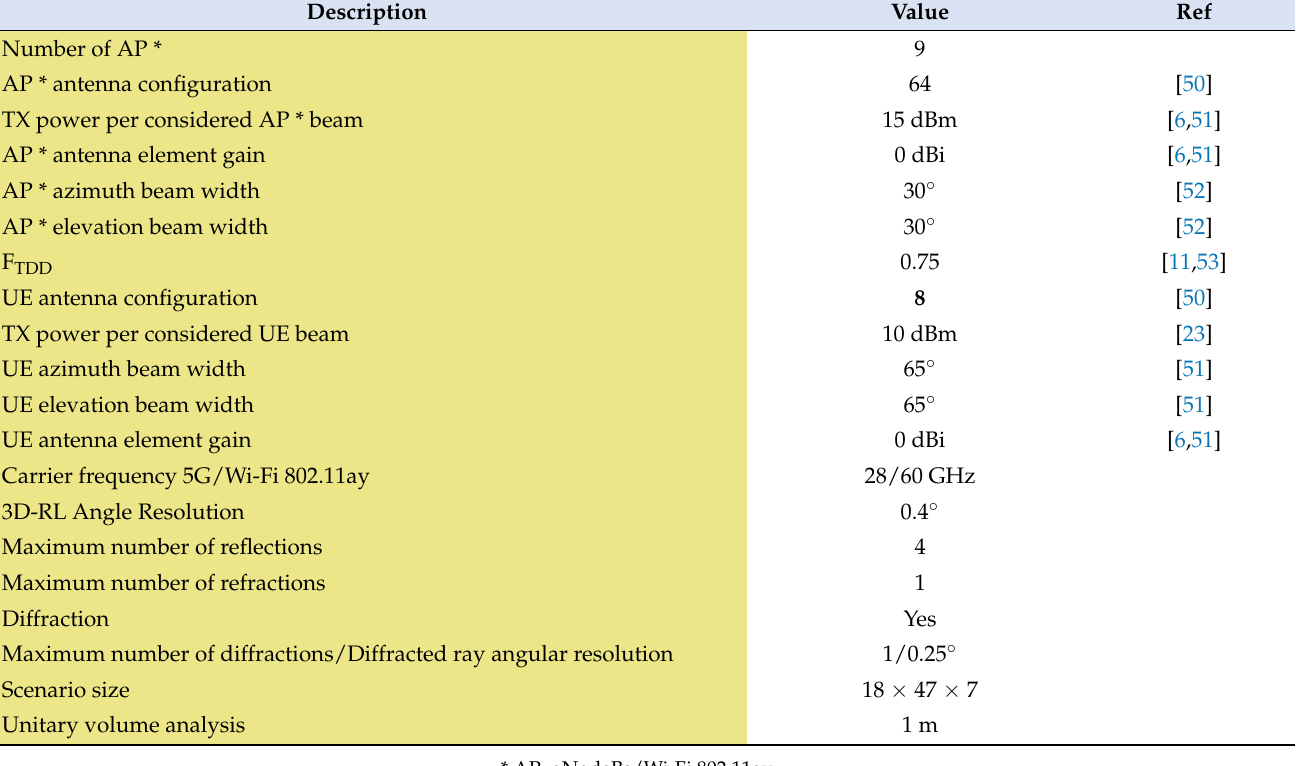
Table 3. Setting of the main input parameters for 5G and Wi-Fi 802.11ay simulation setup in the considered